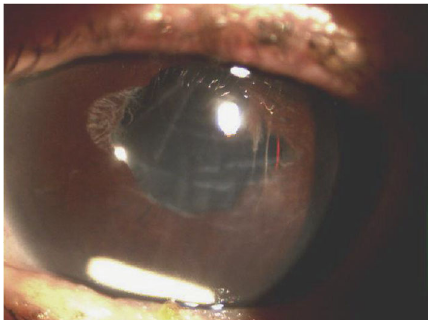
Figure 1: Slit-lamp photograph showing dexamethasone implant migration into the anterior chamber, corneal oedema, and Descemet ’ s membrane